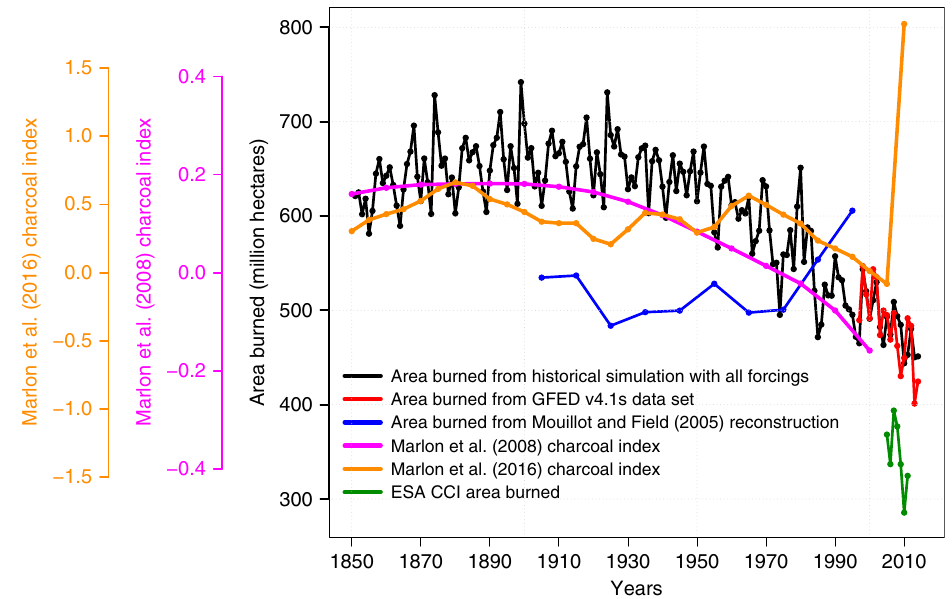
Fig. 2 Comparison of simulated area burned with other observation-based estimates and charcoal indices. The satellite-based products include the GFED 4.1 s 14,15 data set for the period 1997 – 2014 and the European Space Agency ’ s Climate Change Initiative (ESA CCI) for the period 2005 – 2011. Global charcoal indices are from the Global Charcoal Database 12,13 (GCD, based on 2008 12 and 2016 13 publications). The decadal reconstruction of global burned area for the 20th century from Mouillot and Field 26 is based on land use practices, qualitative reports and local